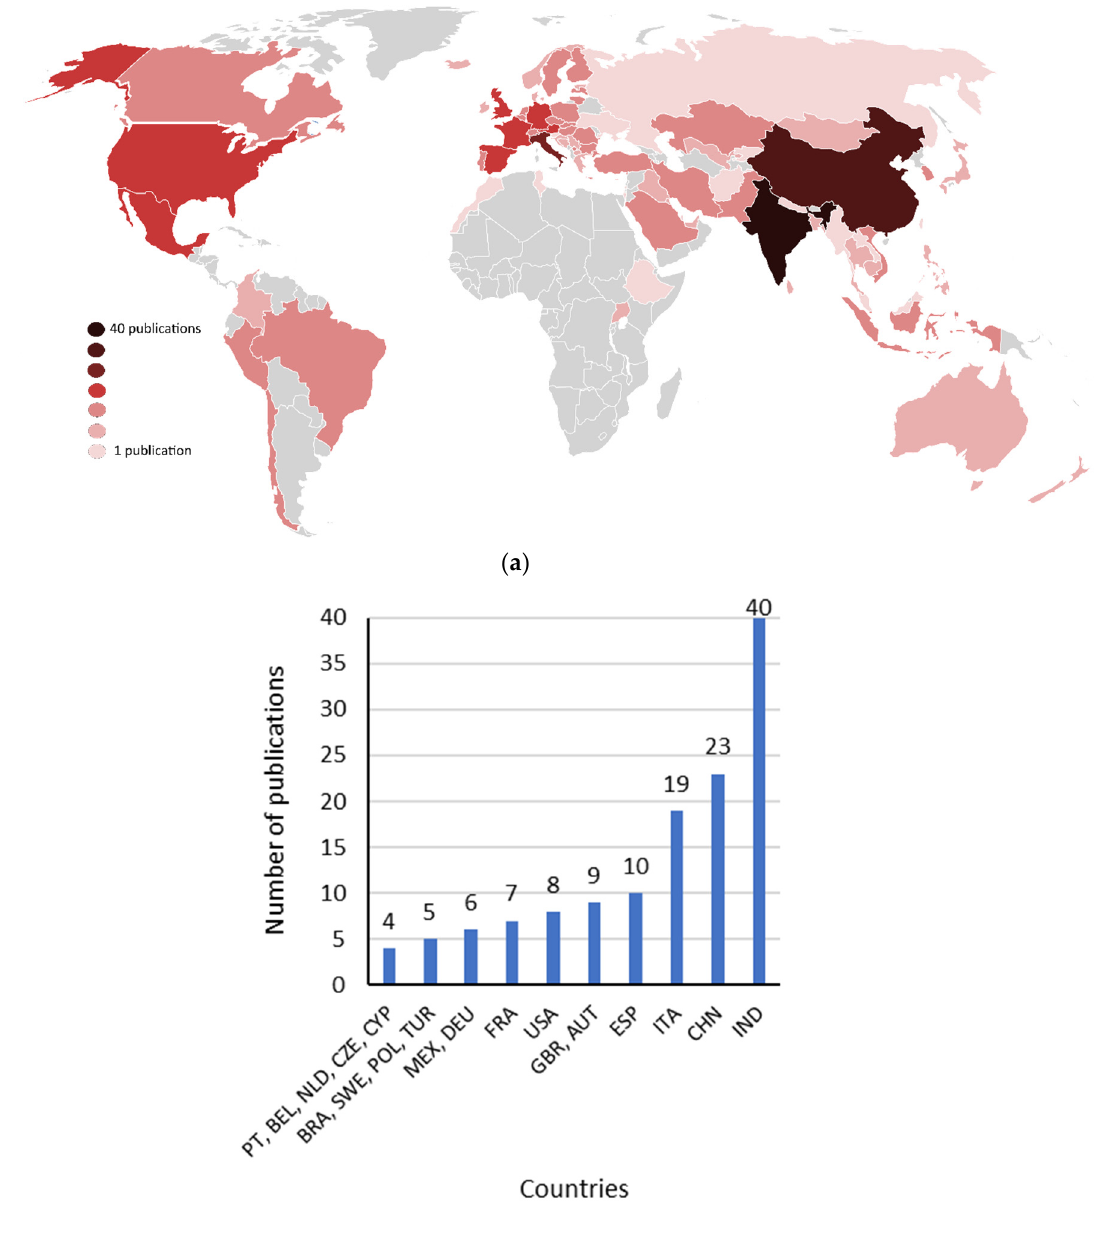
Figure 2. ( a ) Geographic representation on the world map of the studied locations from the 114 articles reviewed; ( b ) number of publications of the studied locations with at least 4 publications.